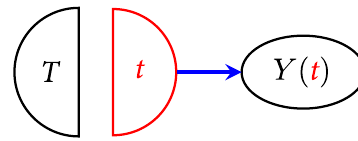
Figure 14: Simple SWIG template, expressing PO ( weak )